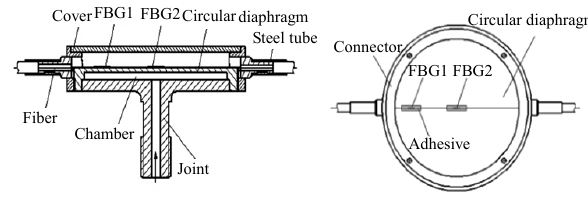
Fig. 8 Structure of the diaphragm-type FBG pressure sensor.